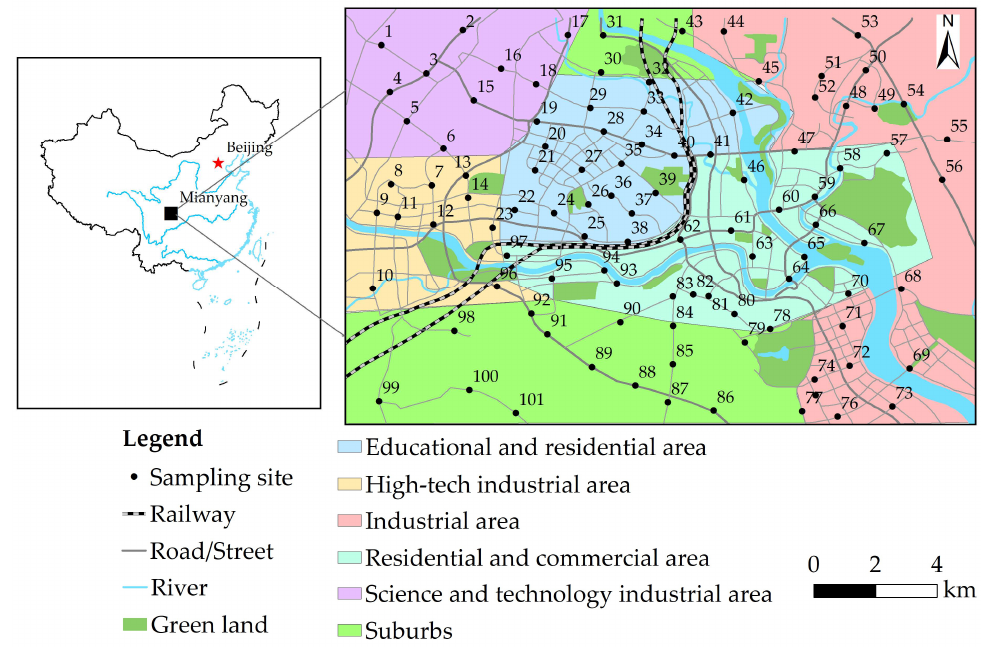
Figure 1. The sampling points in Mianyang urban area, SW China.